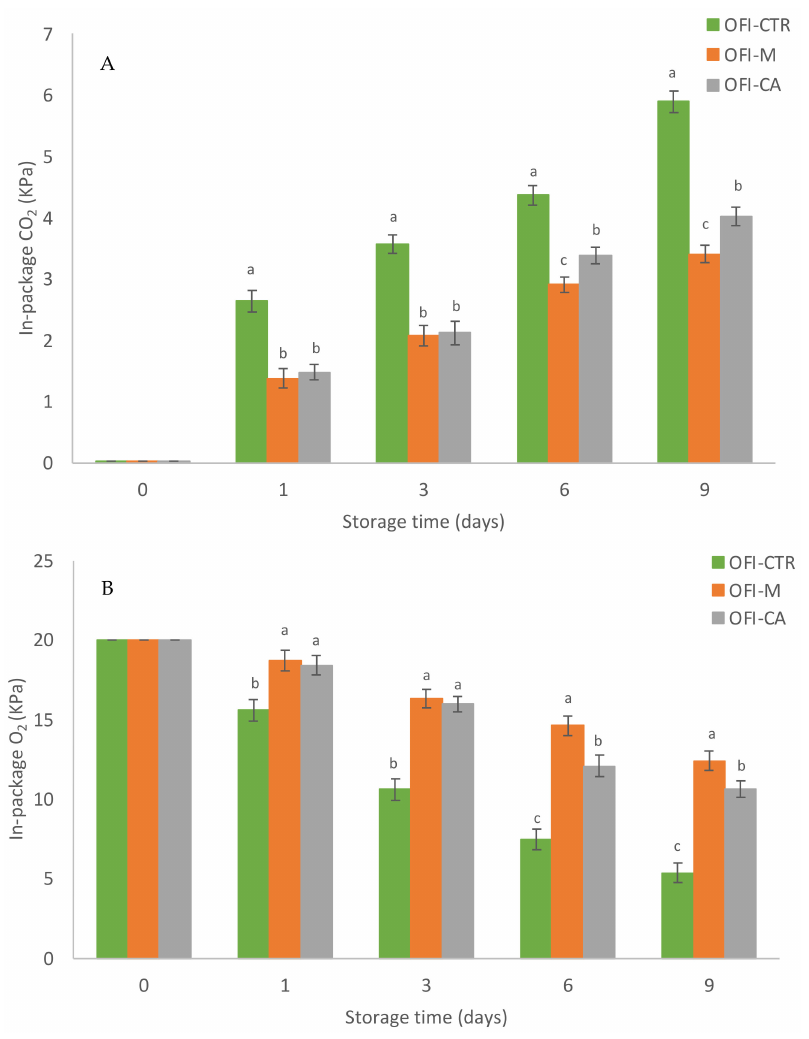
Figure 3. Concentrations of CO 2 ( A ) and O 2 ( B ) in minimally processed O. ficus-indica fruits non- treated (OFI-CTR) and treated with mucilage (OFI-M) and calcium ascorbate coating (OFI-CA) during cold storage (9 days at 5 ◦ C). Different lowercase letters indicate significant differences between the treatments in each sampling date. Data are the mean ± SE ( n =